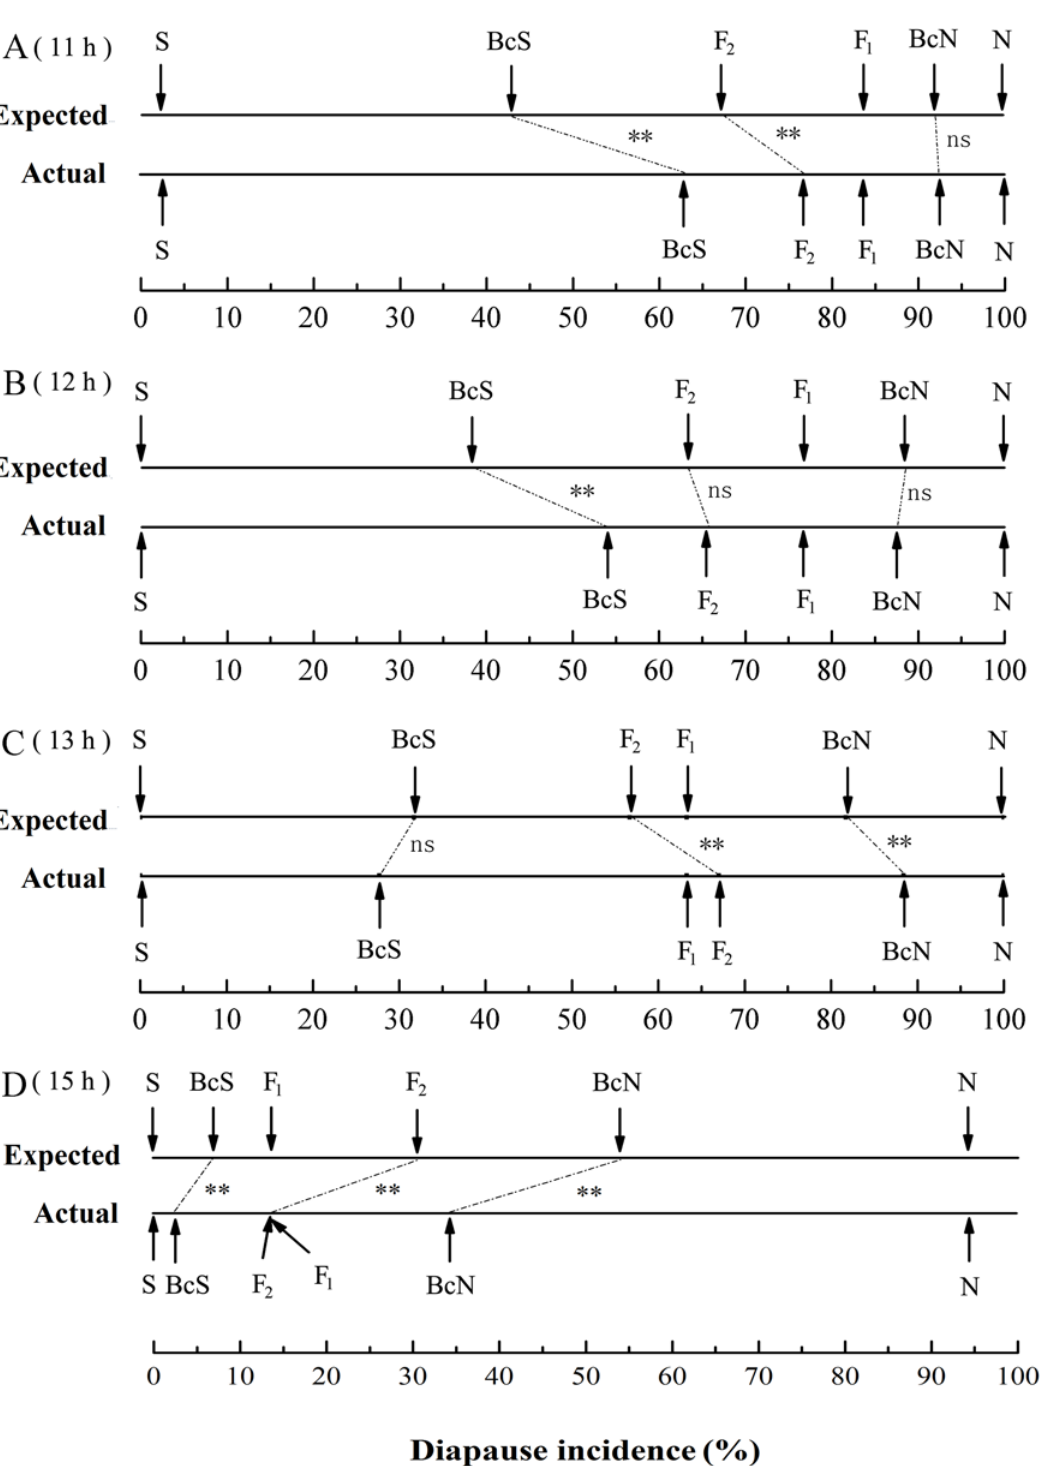
Fig 3. A comparison between the observed diapause incidence under LD 11:13 h (A), LD 12:12 h (B), LD 13:11 h (C) and LD 15:10 h (D) at 25°C among the progeny of crosses involving lines of Ostrinia furnacalis and the results predicted by an additive model with incomplete dominance ( χ 2 -test, ns, not significantly different; ** P < 0. 01) (also see Table 4 – 7). Bc-S, backcross to the southernmost Ledong strain; Bc-N, backcross to the northernmost Harbin strain.